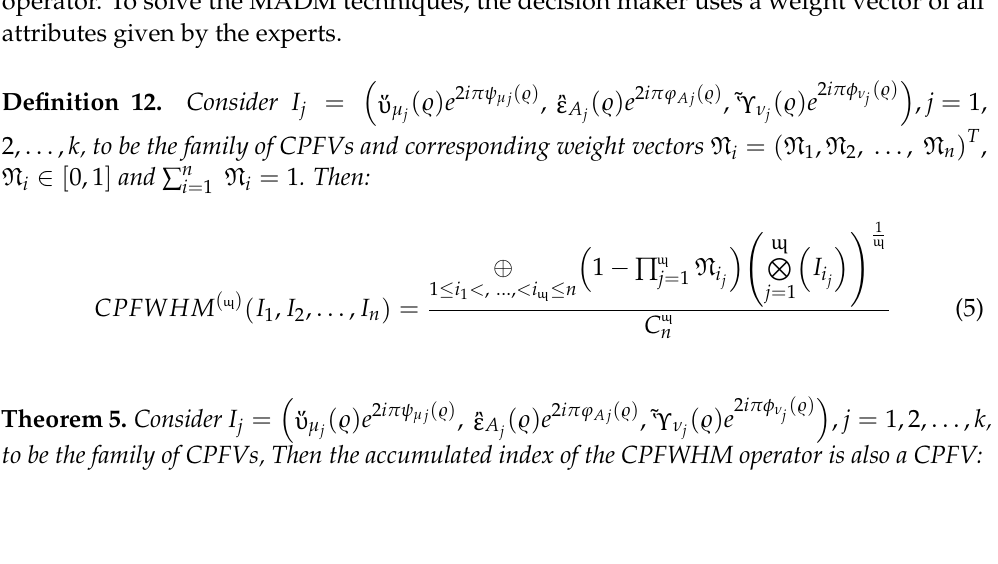
Table 1. Symbols and their